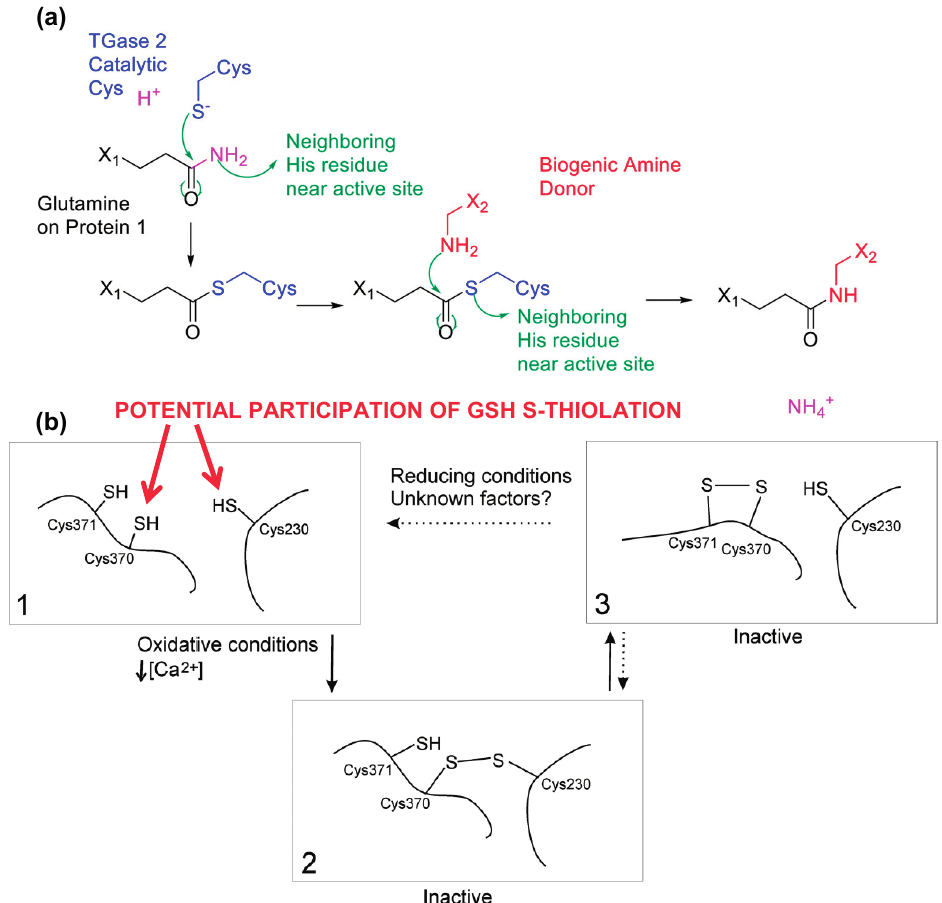
Figure 7. TGase 2 as a case study to demonstrate that Gsp is the key to understand the biochemistry of protein thiols. ( a ) Reaction mechanism of tissue transglutaminase upon activation is initiated by a nucleophilic attack by the activated catalytic cysteine on the glutamine amide. A second stage of nucleophilic attack from an amine donor transforms the thioester intermediate to complete the transamidation reaction; ( b ) A proposed scheme of the role of S -glutathionylation in TGase 2 activity moderation, as modified from [85]. S -glutathionylation at Cys 230 may promote disulfide formation in TGase 2 cysteine triads, providing energetically favorable incremental states to rapidly protect and activate TGase 2 in times of need. The generation of such intermediate states triggered by S -glutathionylation could lead to disulfide bridges among the triad and conformational changes in TGase 2 structure. Cysteine mapping results suggest that Cys 230 remains in potential disulfide bond formation independent of calcium, implying an equilibrium “resting” stage of S -glutathionylation to maintain TGase 2 for rapid activity. Figure 7b was originally published by Stamnaes et al . [85] © The American Society for Biochemistry and Molecular